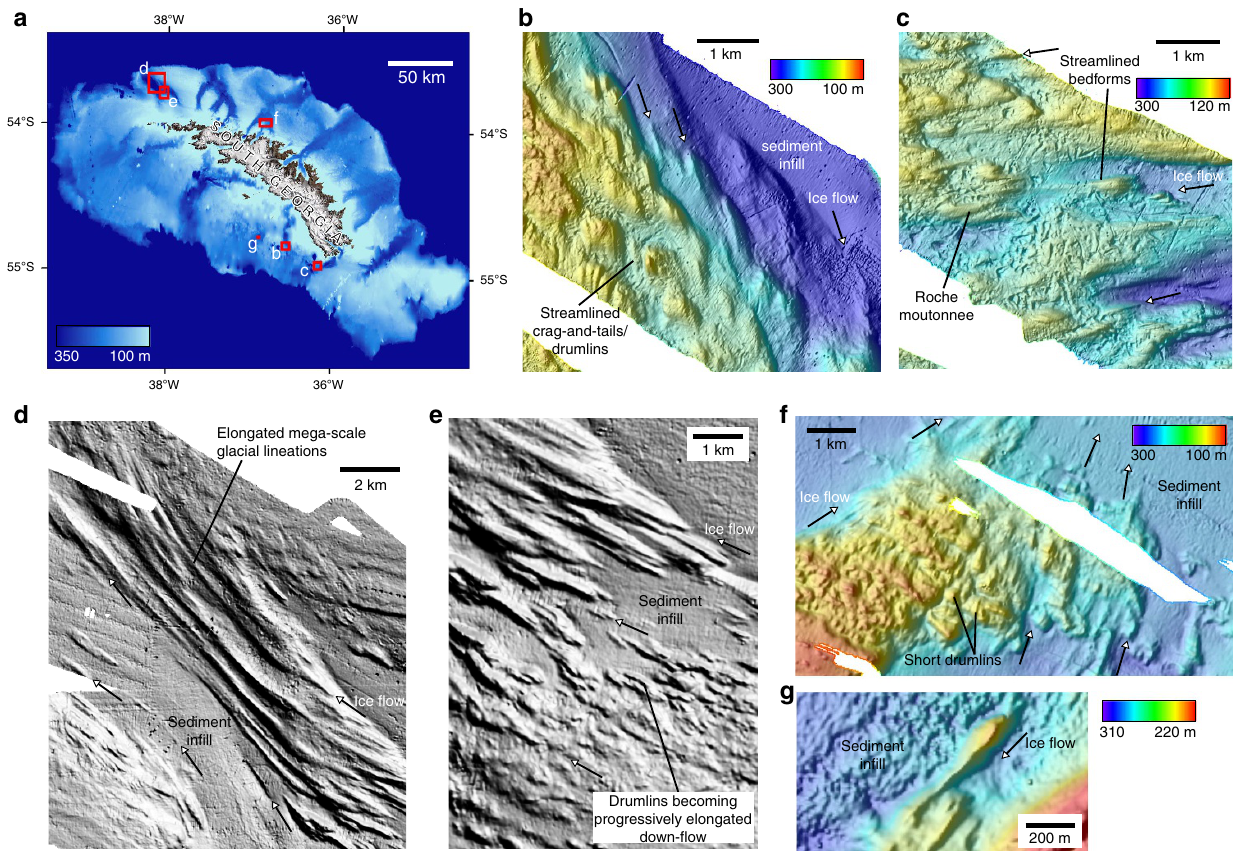
Figure 4 | Multibeam swath bathymetry maps of streamlined subglacial bedforms on the South Georgia shelf. ( a ) Location map indicating the locations of panels b – g . ( b ) Streamlined crag-and-tails and/or drumlins 0.5–1km in length, south of Undine South Harbour; ( c ) streamlined bedforms and roche moutonne´e overprinted by extensive scouring in the trough feeding out of Drygalski Fjord; ( d ) elongated mega-scale glacial lineations and ( e ) drumlinoid bedforms that increase in elongation down-flow in the trough northwest of Church Bay; ( f ) convergence of flow patterns including a swarm of small drumlins at the confluence of tributaries emanating from Possession Bay and Antarctic Bay; ( g ) individual drumlin imaged on flat sea-bed region south of the central part of the island. All multibeam data have an 8m grid-cell size, except for ‘ f ’ which is gridded at 20-m cell size. Arrows depict direction of former ice